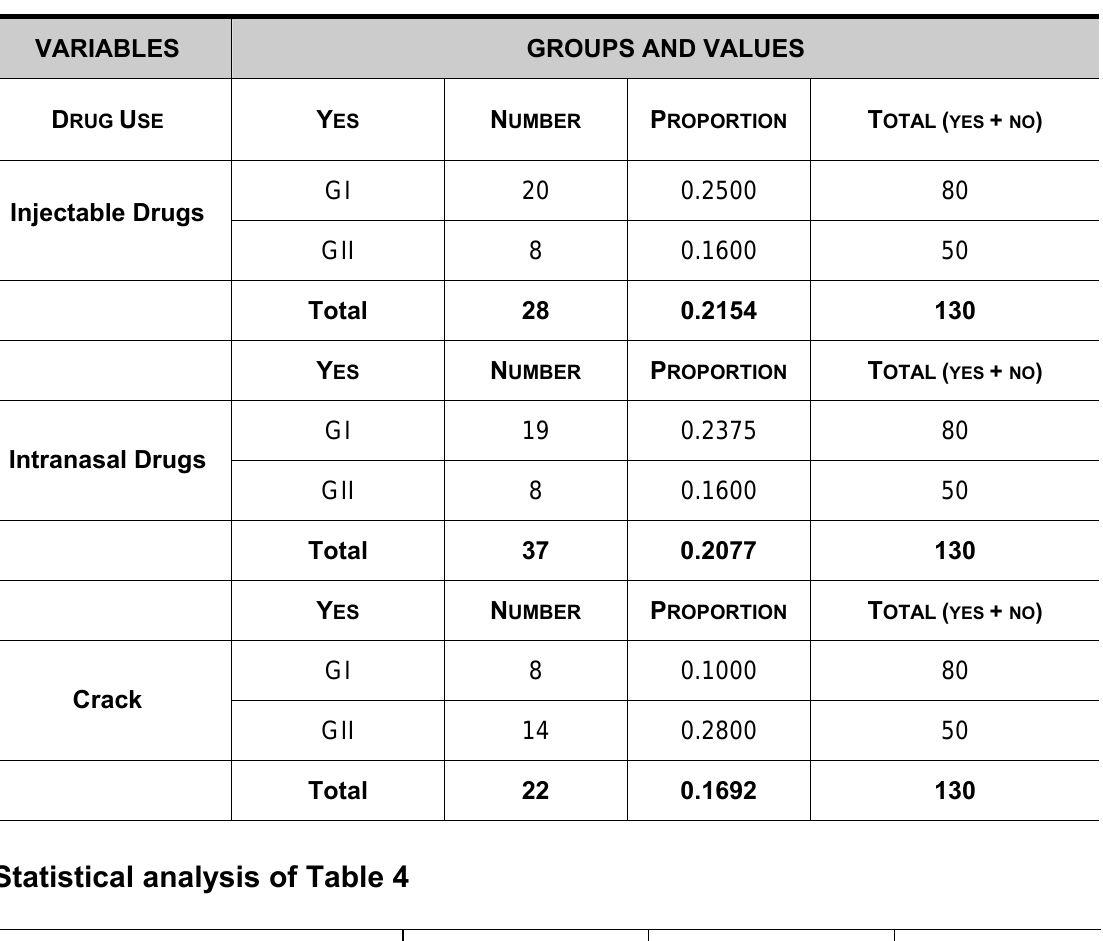
Table 4. Distribution of eighty individuals infected by C virus (GI) and fifty non- infected persons (GII), regarding use of illicit drugs (injectable or intranasal) plus crack (yes or